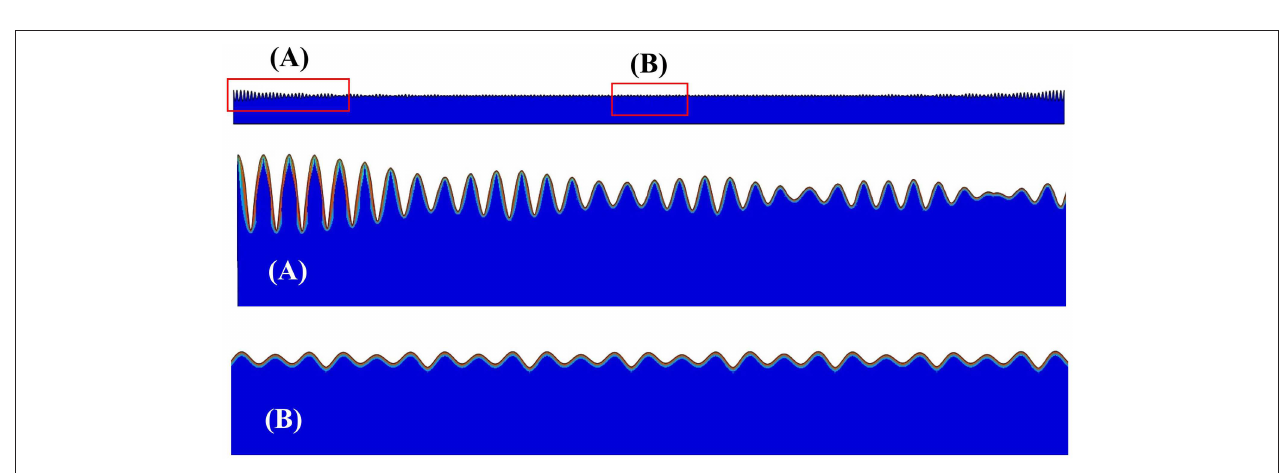
FIGURE 13 | Typical wrinkling configurations on the entire surface region, obtained from the simulations for the models with a bilayer film, and with a very high < 10). (A) Magnified portion of the film near the edge. (B) Magnified portion of the film in the middle section. imperfection density ( S imp λ s